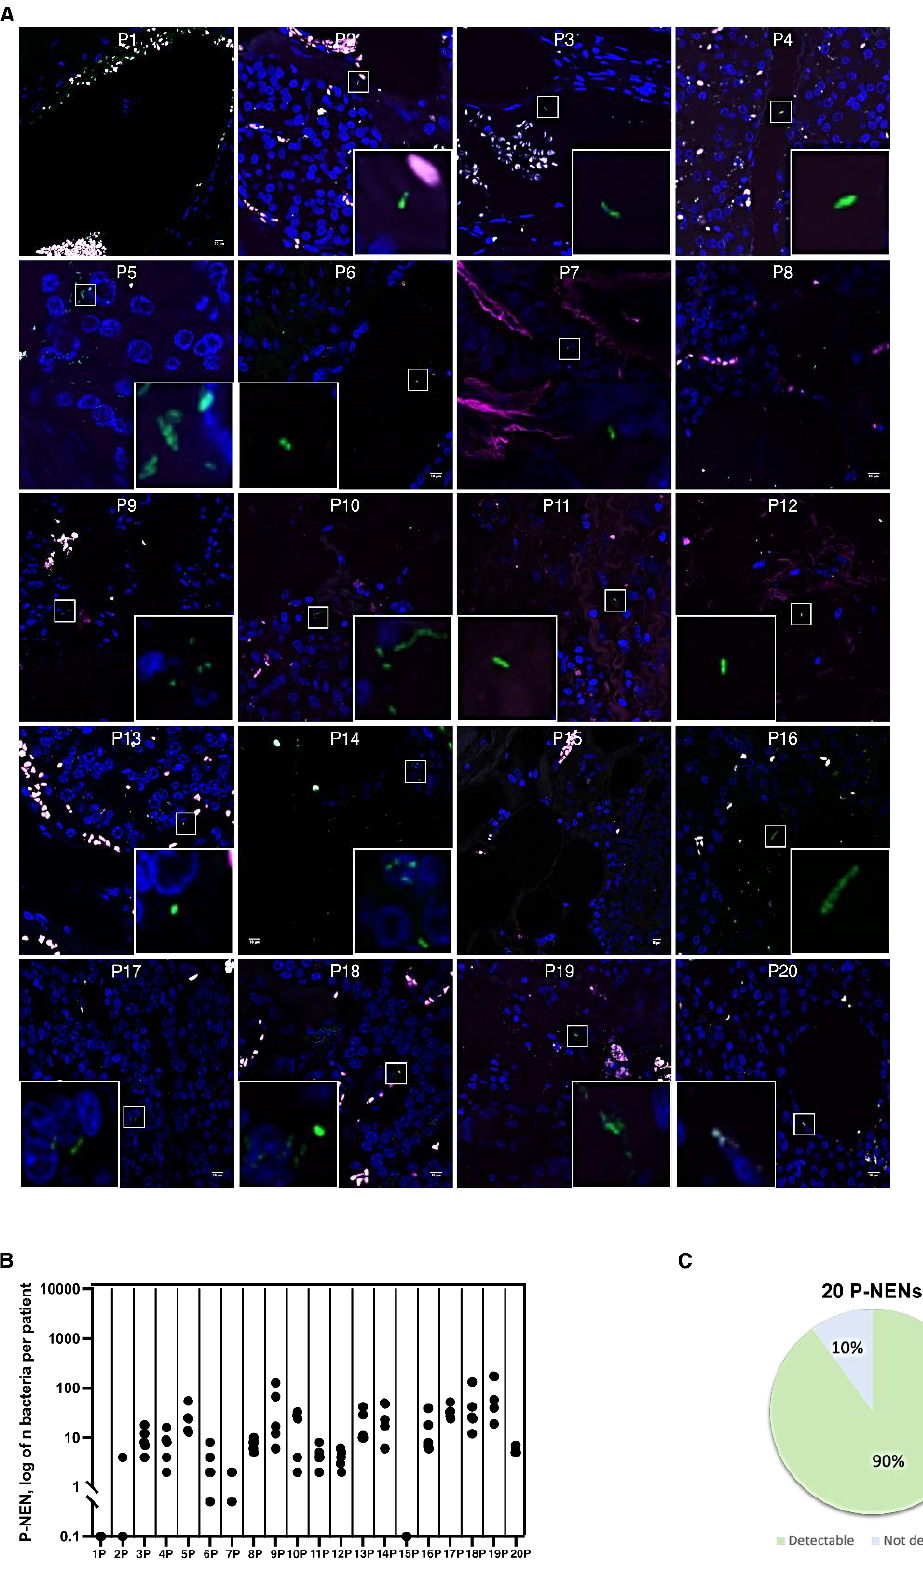
Figure 2. Bacterial count in pan-NEN patients. ( A ) Representative confocal microscopy images of the bacterial signal observed within pan-NEN patients (N = 18). Scale bar = 10 µ m. ( B ) Dot plot representing the log10 normalized bacterial counts per acquired section (N = 5) by FISH in pan-NEN specimens (N = 20). ( C ) Distribution of bacterial occurrence in pan-NEN patients (N =